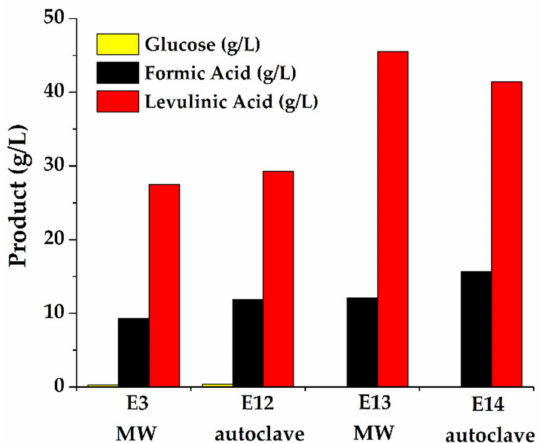
Figure 3. Compositions of the main reaction products of runs E3, E12, E13 and E14 reported in